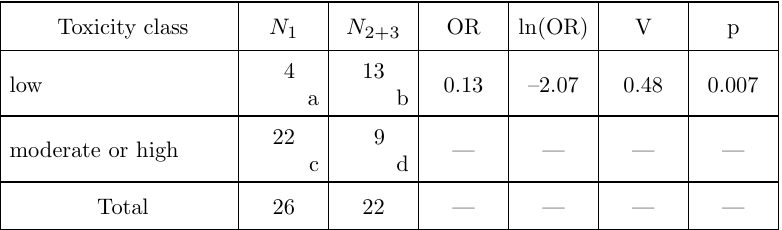
Table 6. Odds ratios (OR) for the third partial criterion under study